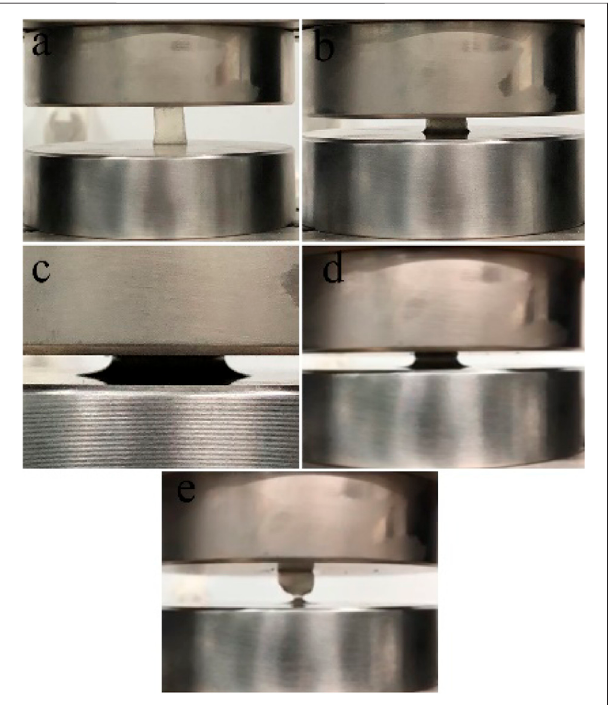
FIGURE 5 | C ompression process of RHK